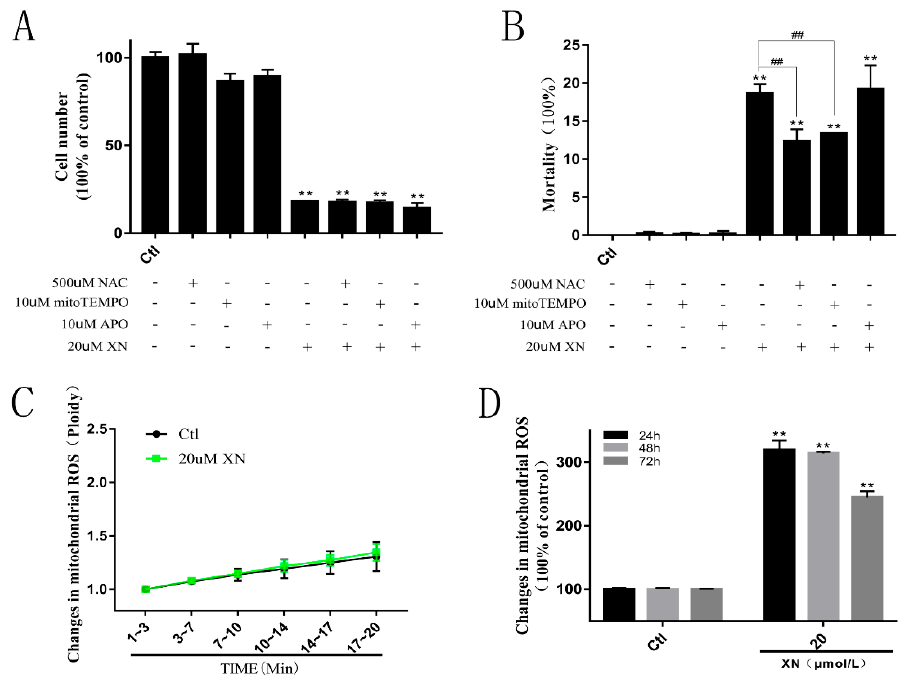
Figure 4. Effects of XN (20 uM) on ROS formation in C6 cells. ( A , B ) The C6 cells were pretreated with 500 uM NAC to scavenge the intracellular total ROS, or 10 uM Mito-Tempo to scavenge the mitochondrial ROS, or 10 uM APO to inhibit the NADPH oxidase for 1.5 h before the co-treatment with XN for another 96 h, and the cell viability and death were measured by trypan blue assay. ( C ) The change of mitochondrial ROS in C6 cells during the initial 20 min of XN incubation was detected by flow cytometry. ( D ) The change of mitochondrial ROS in C6 cells during the 24, 48, and 72 h of XN incubation was detected by flow cytometry. Mitochondrial ROS were labeled by mitoSOX TM . ** p < 0.01 vs. control groups. All data presented are the mean ± SEM from three independent experiments. ## p < 0.01 vs. XN-treated group.